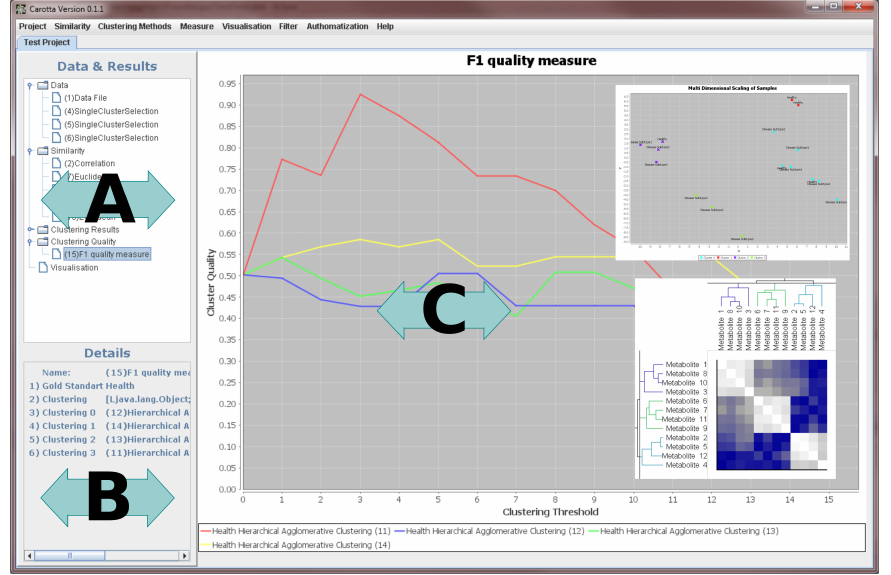
Figure 3. The graphical user interface is split into three basic regions: ( A ) the data and results area lists available (intermediate and final) results; ( B ) a “details” panel; ( C ) the main result visualization